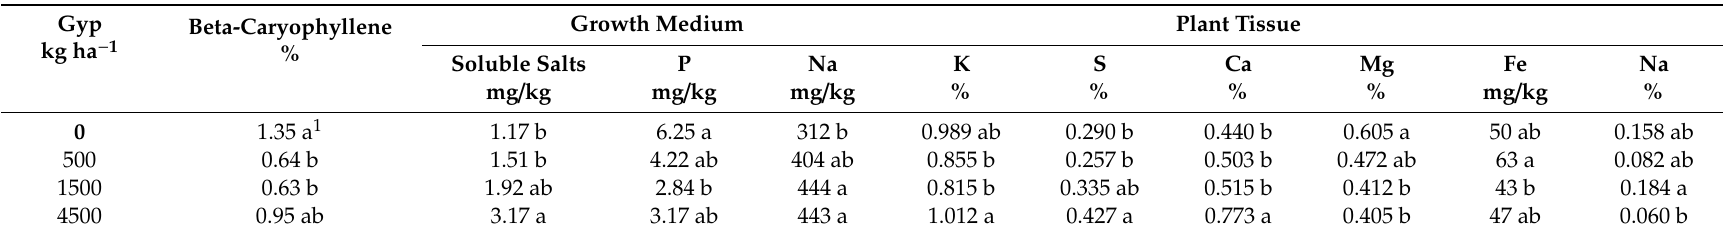
Table 9. Mean Beta-Caryophyllene content in palmarosa essential oil, growth medium-available nutrients [soluble salts, phosphorus (P), and sodium (Na)], and plant tissue nutrient content [potassium (K), sulfur (S), calcium (Ca), magnesium (Mg), iron (Fe), and Na] obtained from the four levels of gypsum (Gyp) application in the palmarosa experiment.